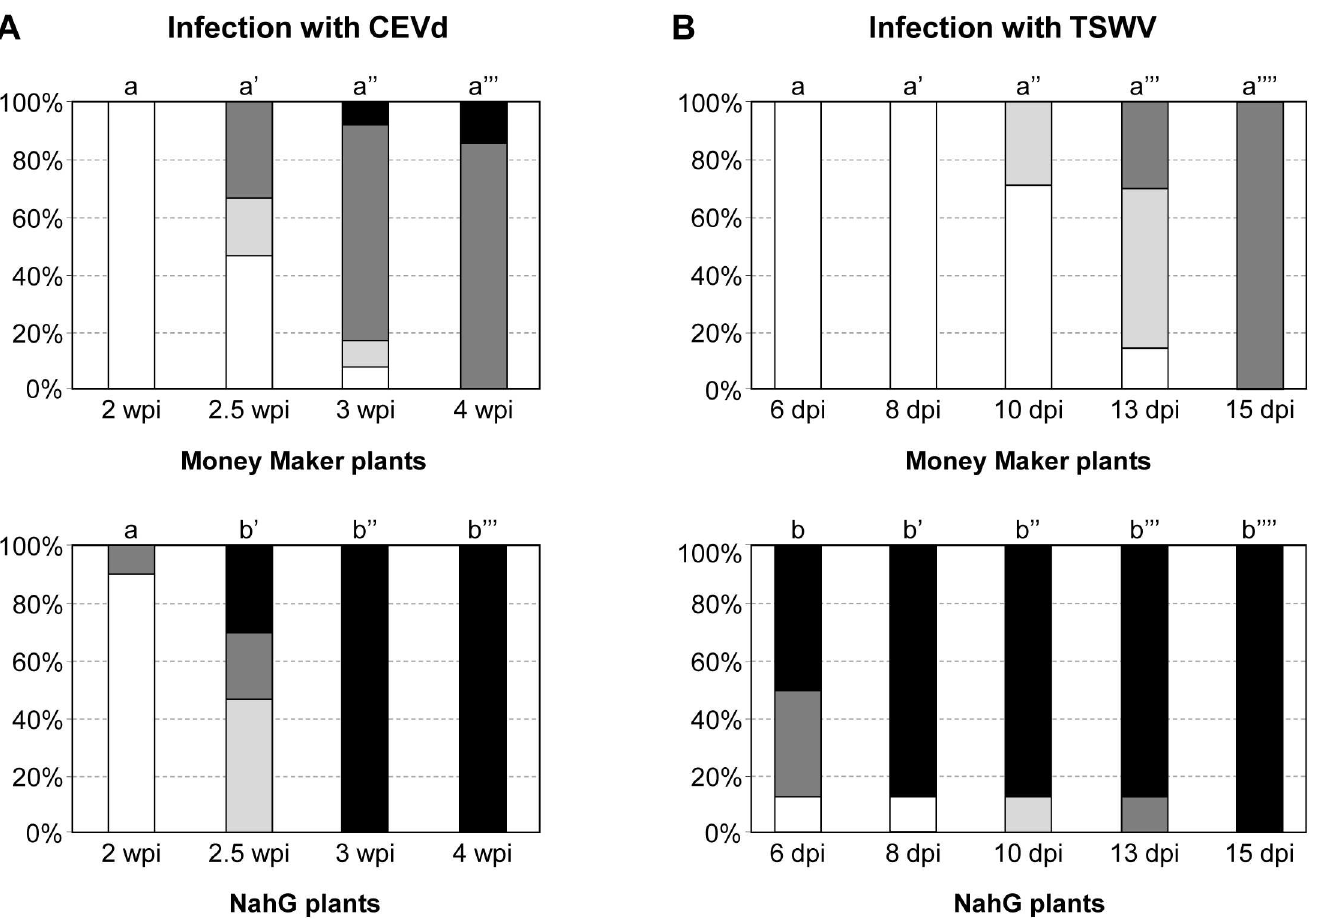
Fig 3. Diseaseseverityof infected Money Maker and NahG tomato plants. Symptoms scale provokedby A) Citrus Exocortis Viroid (CEVd) and B) Tomato Spotted Wilt Virus (TSWV). Symptomatology was scored at 2, 2.5, 3, and 4 weeks post-inoculation (wpi) with CEVd and at 6, 8, 10, 13, and 15 days post-inoculation (dpi) with TSWV using the followingscale: symptomless (white), moderate(grey), severe (dark gray), and very severe (black). Data of a representative experiment are shown. A Kruskal-Wallis analysiswas performed and different letters indicatesignificantdifferences( p < 0.05) between the Money Maker and NahG plants. The experiments were repeated at least 3